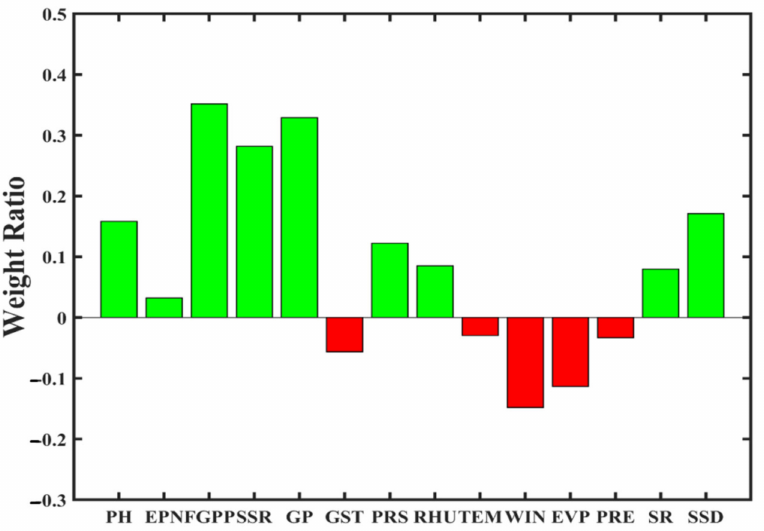
Figure 8. Weight ratio from the PLSR model for training and testing sets using fused climate data and agronomic trait data. GST, ground surface temperature ( ◦ C); PRS, pressure of the station (hPa); RHU, relative humidity (%); TEM, temperature ( ◦ C); WIN, wind speed (m/s); EVP, evaporation (mm); PRE, precipitation (mm); SR, solar radiation (MJ/m 2 ); SSD, sunshine duration (hour); YIELD, rice yield (ton/ha); PH, plant height (cm); EPN, effective panicle number (ten thousands/hm 2 ); FGPP, filled grains per panicle (grains); SSR, seed set rate (%); GP, growth period